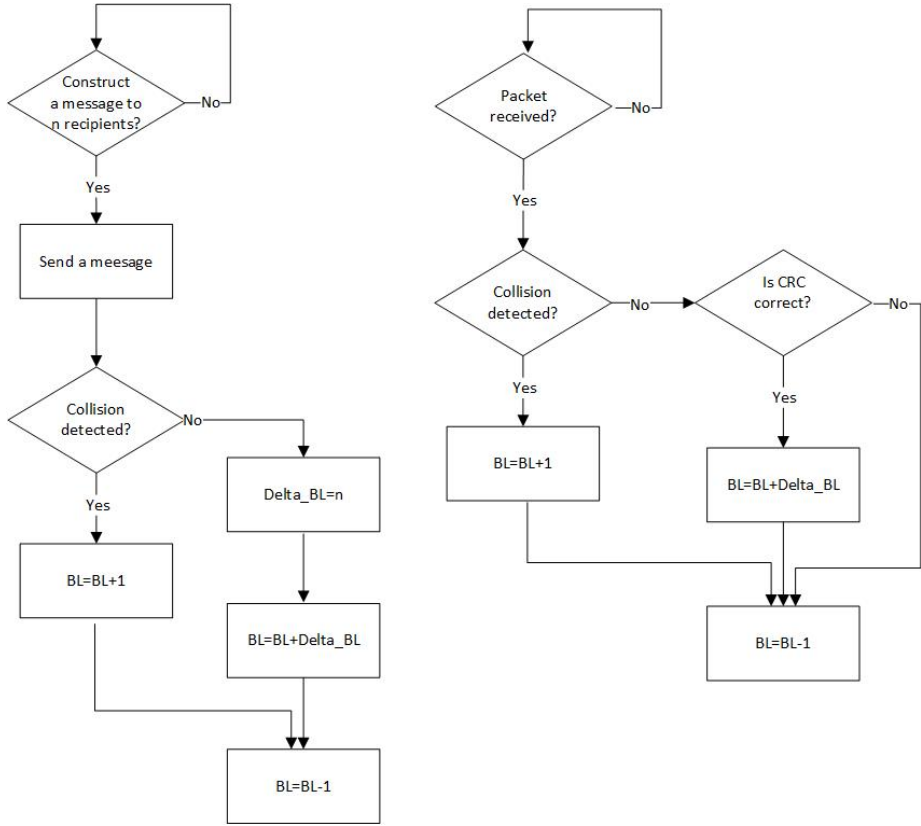
Figure 2. Backlog counting algorithm for transmitting nodes ( left diagram) and receiving nodes ( right diagram) if they are able to detection collisions.